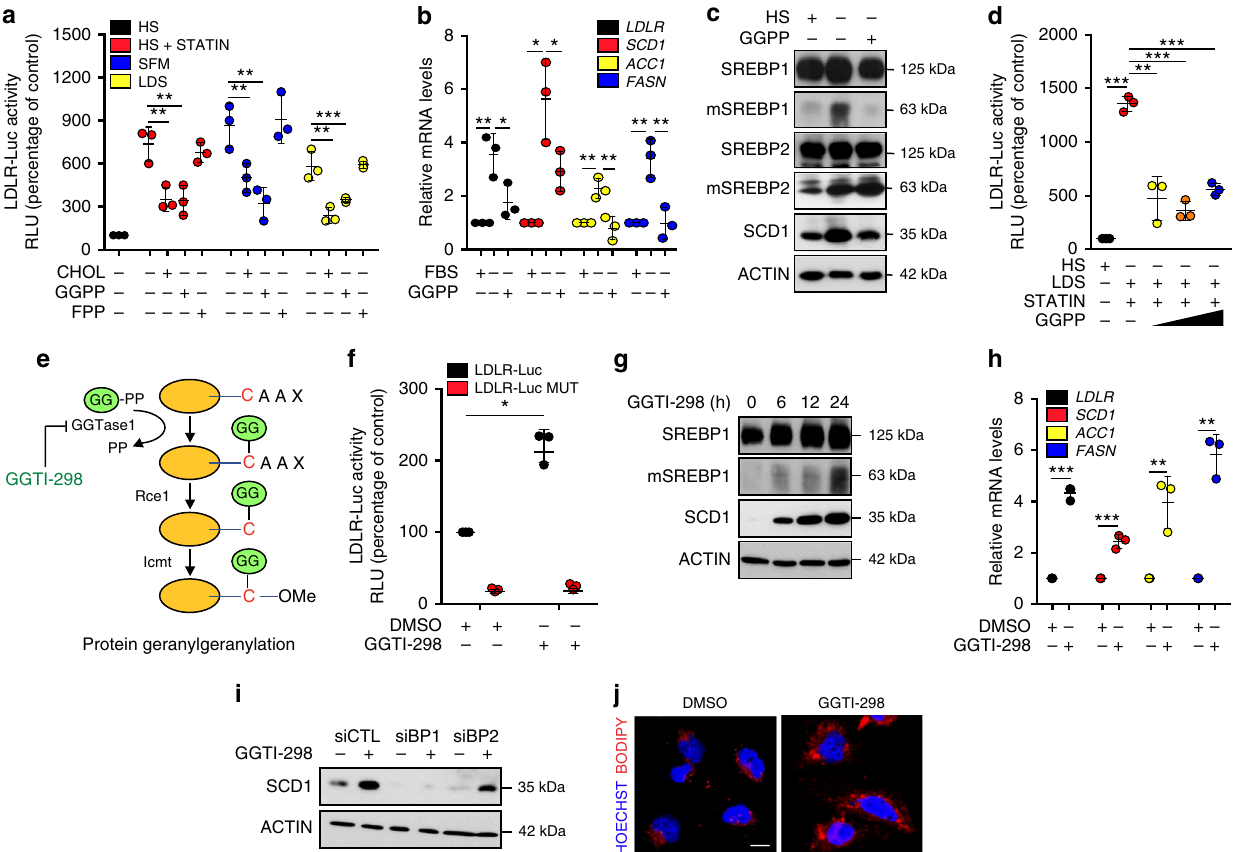
Fig. 1 Protein geranylgeranylation regulates SREBP1. a Low density lipoprotein receptor promoter-luciferase (LDLR-Luc) assay in MCF-10A cells. Medium containing 5% horse serum (HS, as control) was replaced with 5% HS medium supplemented with 10 μ M cerivastatin (STATIN), serum-free medium (SFM) or 2% lipid serum (lipid-depleted serum, LDS) medium, for 24 h. Cells were either mock-treated, or treated with cholesterol (CHOL), geranylgeranyl pyrophosphate (GGPP) or farnesyl pyrophosphate (FPP). b RT-qPCR quanti fi cation of LDLR , SCD1 , ACC1 and FASN gene expression in MCF-10A cells. c Western blot analysis of MCF-10A cells. d LDLR-Luc assay in MCF-10A cells. 5% HS medium (control) was replaced with medium supplemented